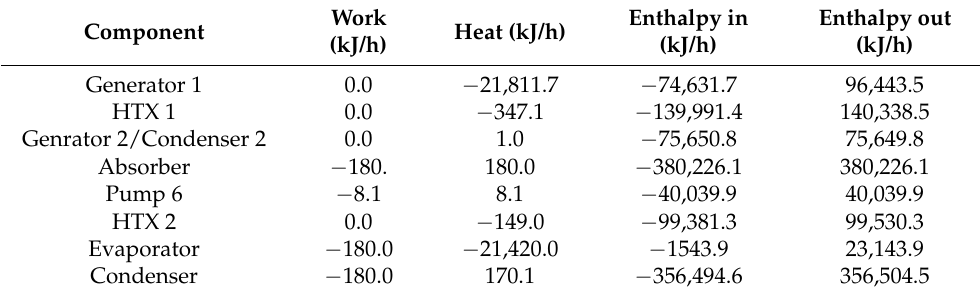
Table 7. Energy conservation for each component in the industrial double-effect LiBr–water absorp- tion refrigerant system shown in Figure 2 (Cooling capacity is 6.0